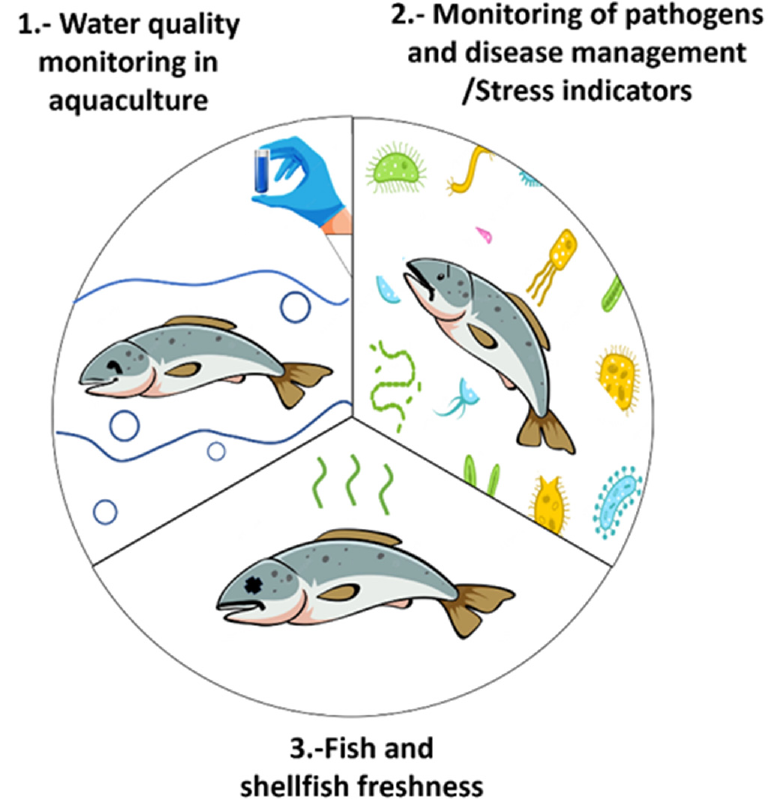
Figure 1. Major areas of interest in aquaculture monitoring.